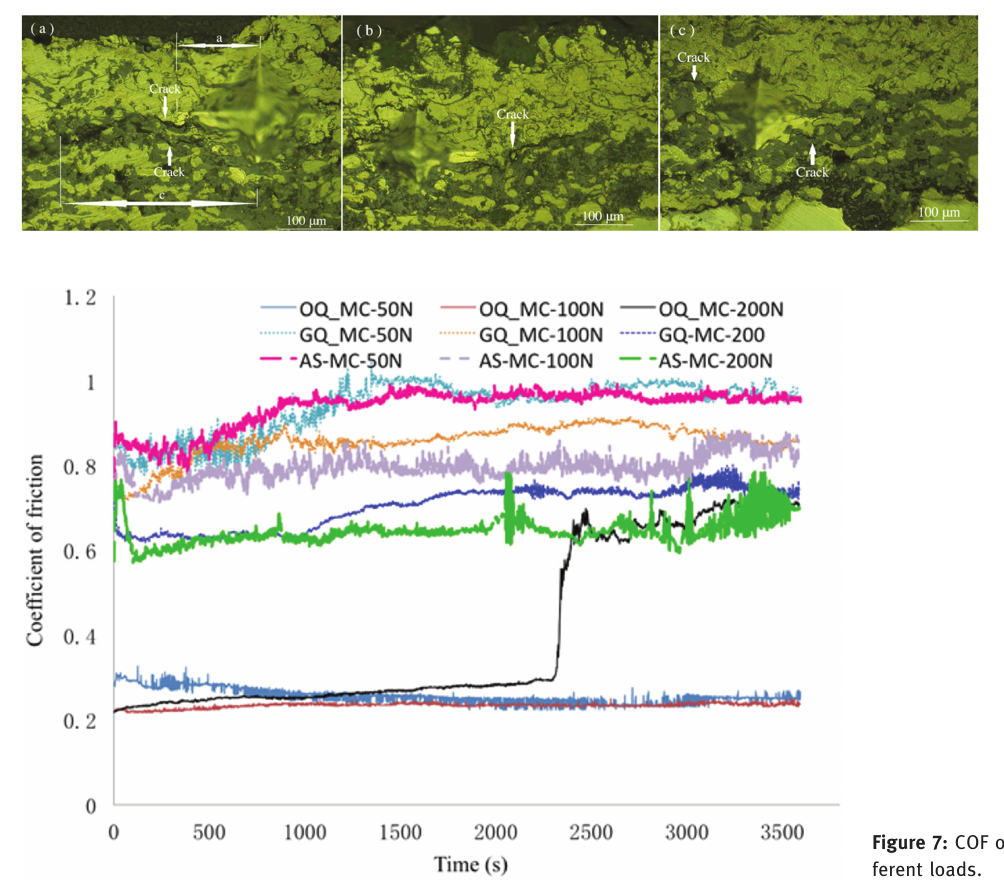
Figure 7: COF of specimens against dif- ferent